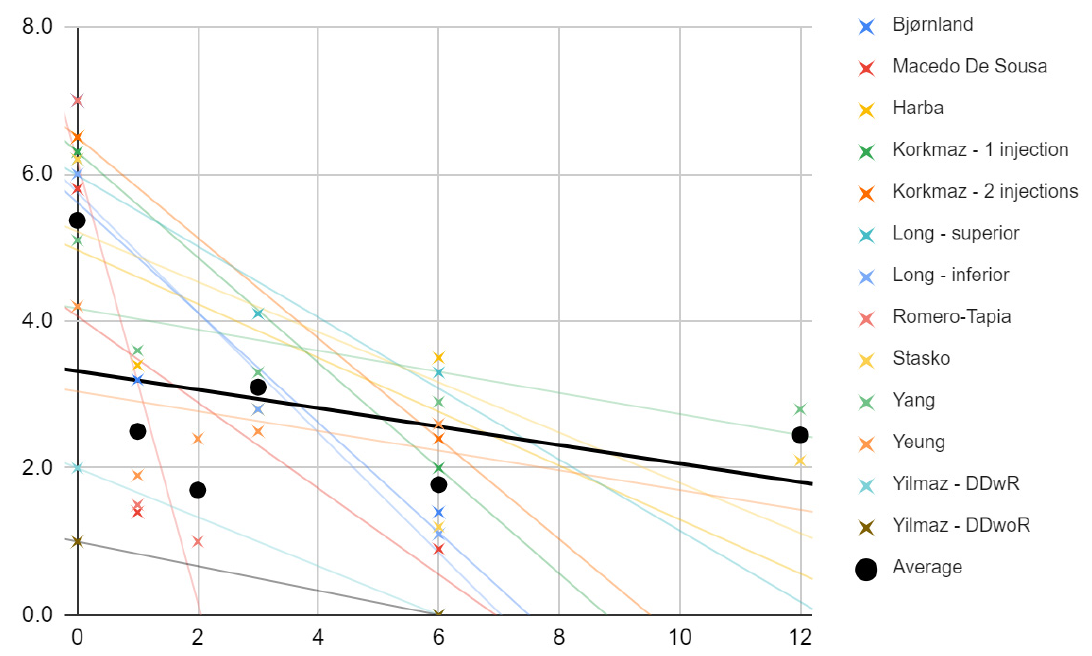
Figure 2. Change in pain intensity (VAS) over time (months). Description in the text.